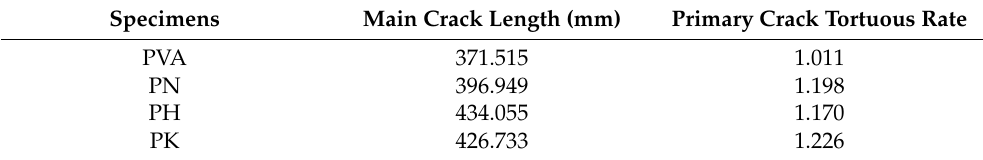
Table 5. Main crack tortuosity of specimens with 1% fiber